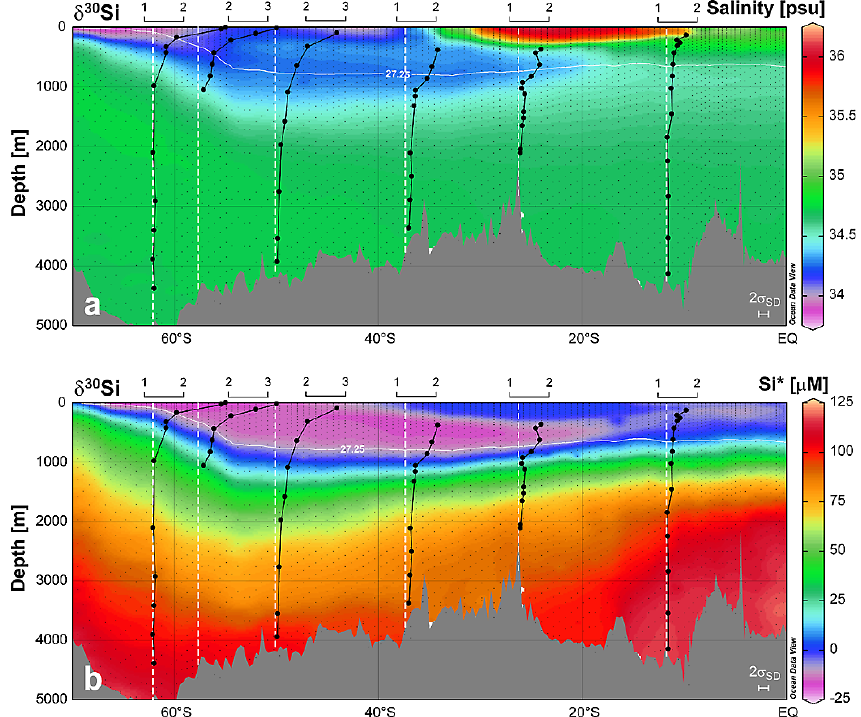
Fig. 3. Depth profiles of δ 30 Si overlain on color maps of (a) salinity and (b) Si ∗ =[Si] − [NO 3 ]. The white line in each profile marks the sampling position as well as a δ 30 Si value of +1.22‰, corresponding to CDW (de Souza et al., 2012). The solid white line traces the γ n = 27 . 25kgm − 3 surface. GR is the Gal´apagos Rise; EPR is the East Pacific Rise. Color map data are from the CLIVAR & Carbon Hydrographic Data Office